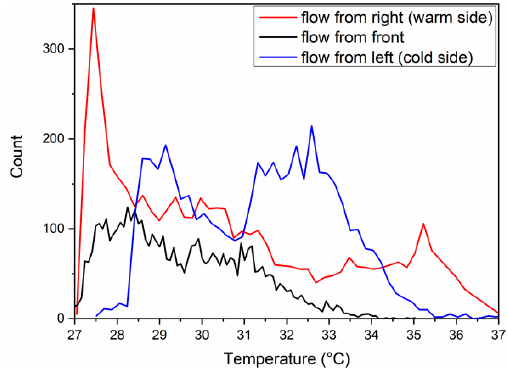
Figure 8. Histogram of the surface temperatures from the face.